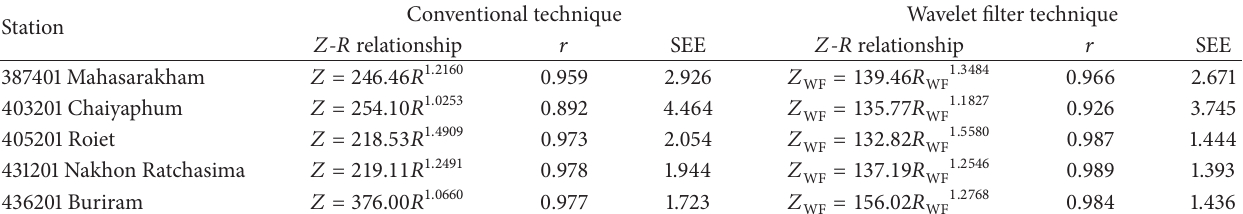
Table 4: Result of statistical 𝑍 - 𝑅 relationship for each station during June–October 2011 period verification.